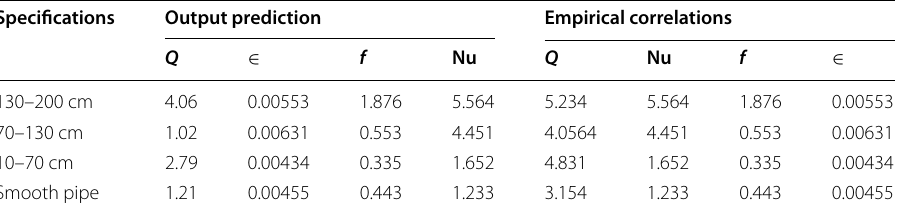
Table 2 Comparison is made between the MSE of ANN predicted model and experimental correlations with and without using bumpers